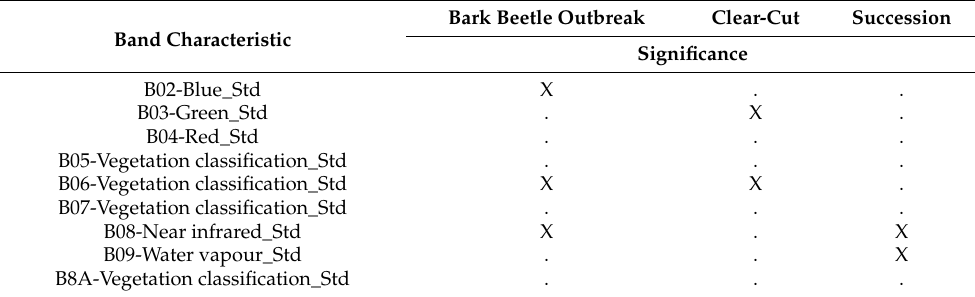
Table 6. A list of band characteristics used for the description of qualitative habitat changes. Charac- teristics that changed significantly between original and updated data are marked by an X mark. Band Characteristic